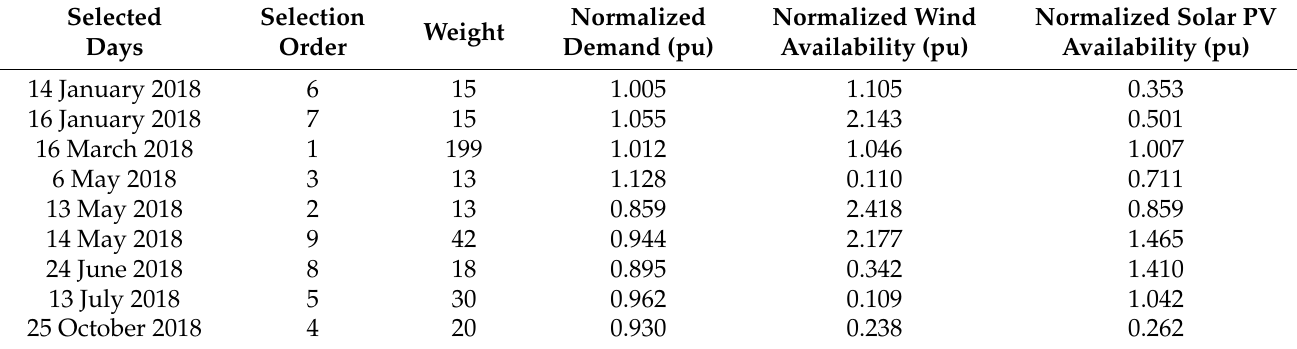
Table 7. Selection of characteristic